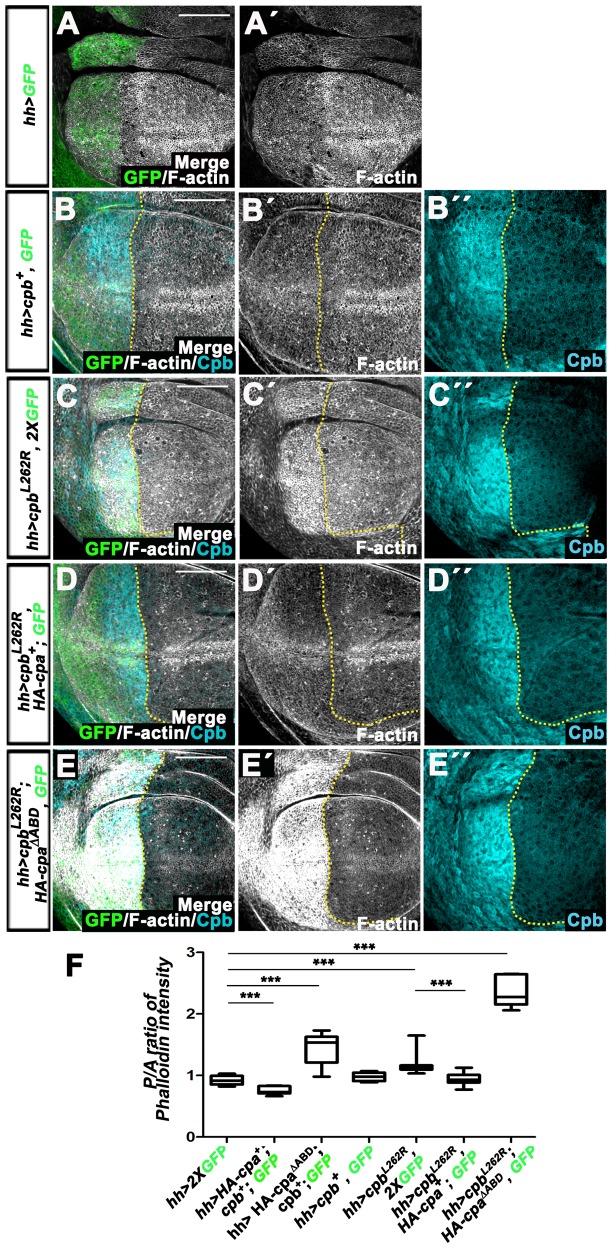
Overexpressing HA-cpa suppresses the apical F-actin accumulation of cpbL262R-expressing wing discs, whereas HA-cpaΔABD expression has the opposite effect.(A–A″ to E–E″) standard confocal sections of the apical cell membrane of third instar wing imaginal discs with dorsal sides up and posterior sides to the left, expressing (A–A′) one copy of UAS-mCD8-GFP (green in A) or (B–B″) UAS-cpb7 and one copy of UAS-mCD8-GFP (green in B) or (C–C″) UAS-cpbL262R and two copies of UAS-mCD8-GFP (green in C) or (D–D″) UAS-cpbL262R, UAS-HA-cpa89E and one copy of UAS-mCD8-GFP (green in D) or (E–E″) UAS-cpbL262R, UAS-HA-cpaΔABD and one copy of UAS-mCD8-GFP (green in E) under hh-Gal4 control. Discs are stained with Phalloidin (white) to mark F-actin and (B–B″ to E–E″) anti-Cpb (cyan blue). The yellow lines outline the anterior-posterior compartment boundary. The scale bars represent 30 µm. (F) Mean intensity of the ratio of Phalloidin signal between posterior and anterior wing compartments of hh-Gal4 driving two copies of UAS-mCD8-GFP (lane 1) or UAS-HA-cpa89E, UAS-cpb7 and one copy of UAS-mCD8-GFP (lane 2) or UAS-HA-cpaΔABD, UAS-cpb7 and one copy of UAS-mCD8-GFP (lane 3) or UAS-cpb7 and one copy of UAS-mCD8-GFP (lane 4) or UAS-cpbL262R and two copies of UAS-mCD8-GFP (lane 5) or UAS-cpbL262R, UAS-HA-cpa89E and one copy of UAS-mCD8-GFP (lane 6) or UAS-cpbL262R, UAS-HA-cpaΔABD and one copy of UAS-mCD8-GFP (lane 7). The mean for lane 1 is 0.922 (n = 12) for lane 2 is 0.775 (n = 8), for lane 3 is 1.435 (n = 10), for lane 4 is 0.977 (n = 10), for lane 5 is 1.175 (n = 16), for lane 6 is.0.937 (n = 14), for 7 is 2.348 (n = 6). Error bars indicate s.e.m.. *** indicate P<0.0001.